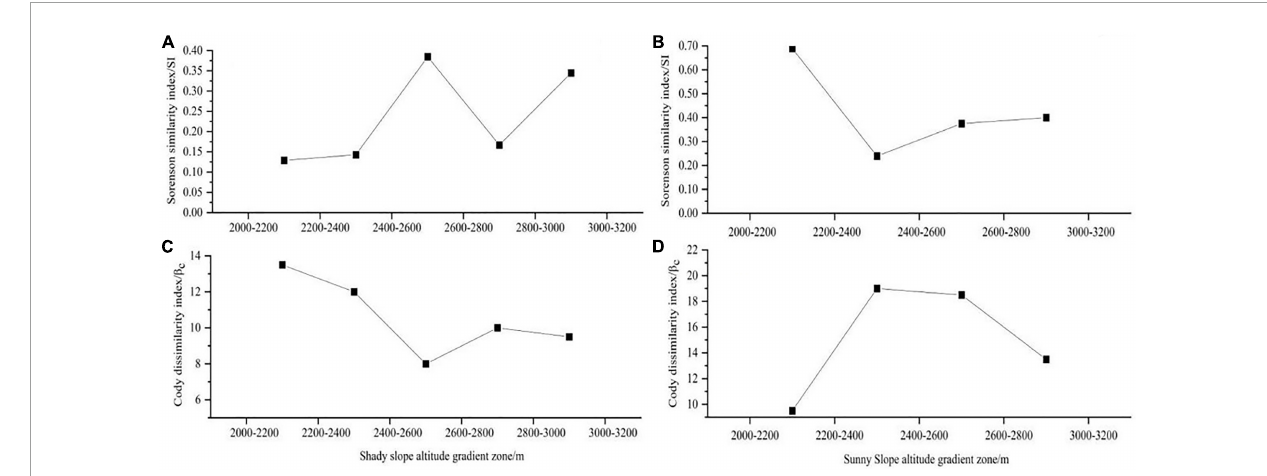
FIGURE6 β diversity index of herbaceous plants in different altitude gradients. Panels (A,C) are Sorenson similarity index and Cody dissimilarity index on shady slope, and panels (B,D) are Sorenson similarity index and Cody dissimilarity index on sunny slope.